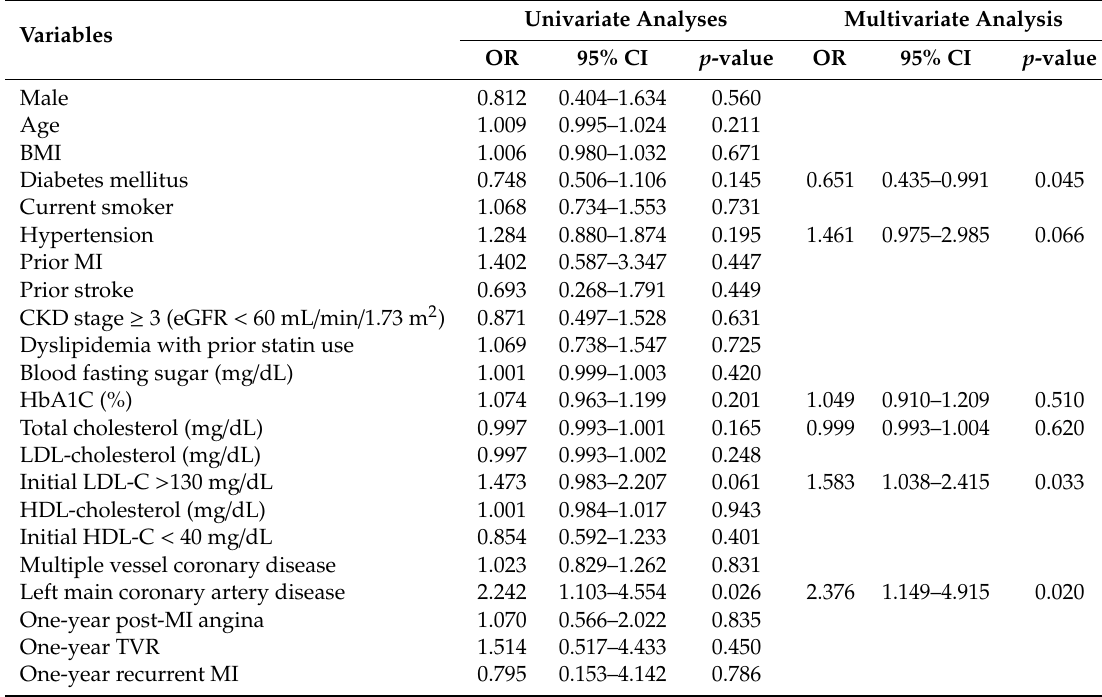
Table 5. The univariate and multivariate logistic regression analyses of associations for non-achievement of LDL-C